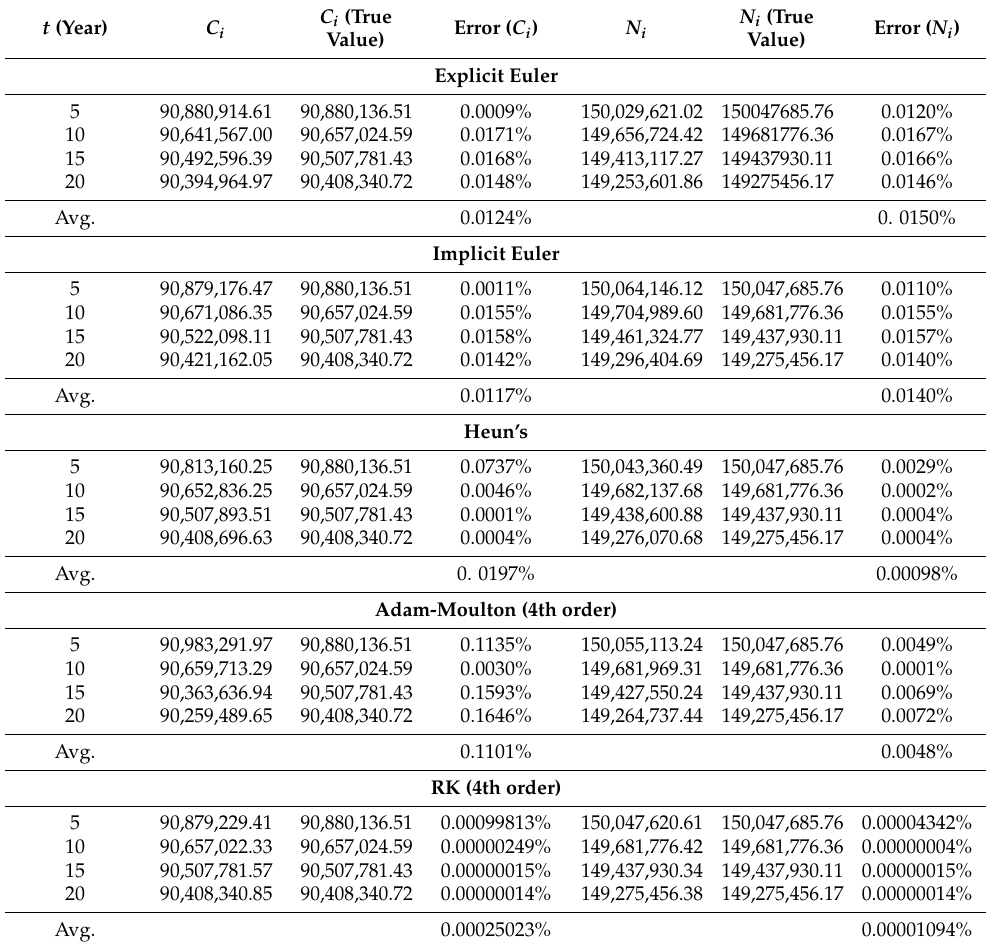
Table 3. The results using the five